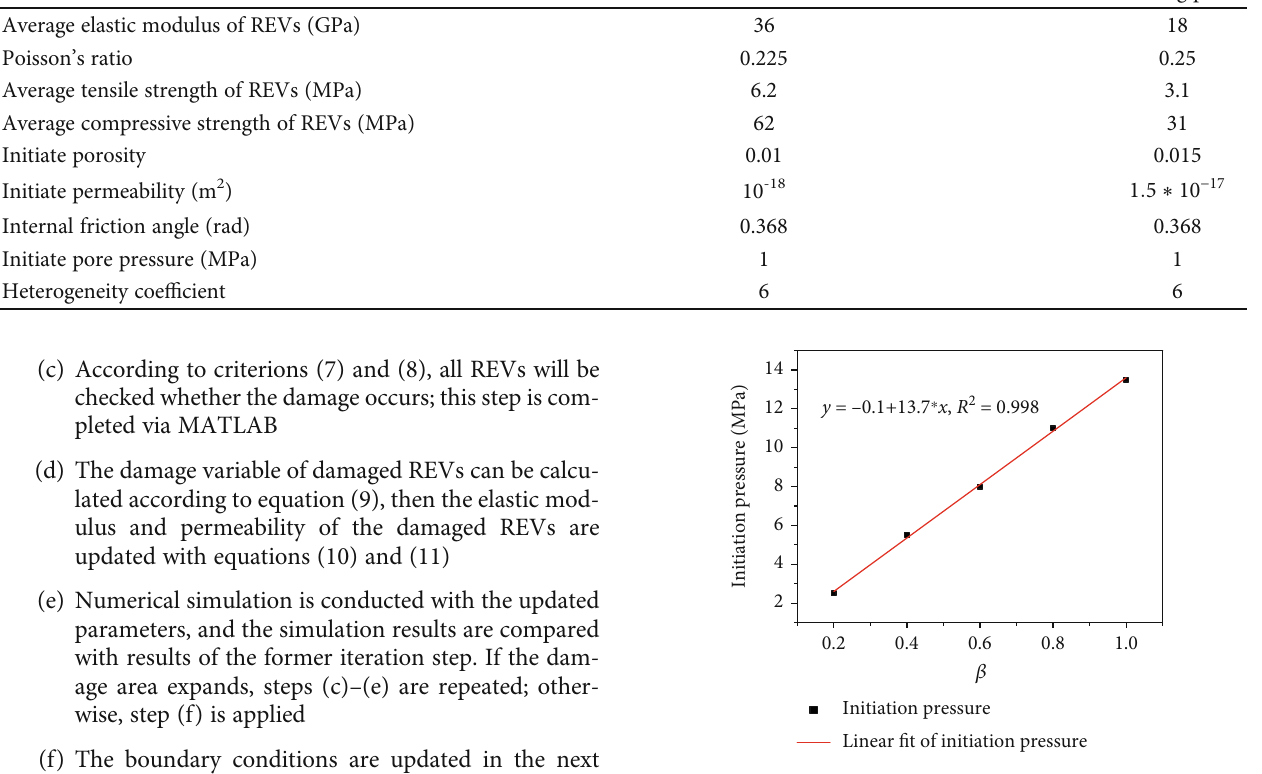
Figure 7: The fracture initiation pressure of specimen versus stress ratio β